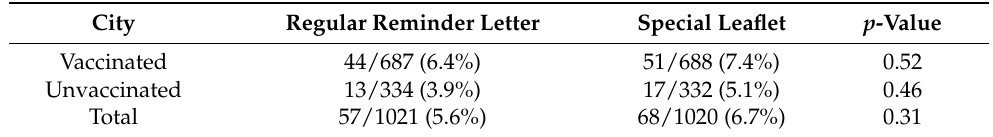
Table 5. Cervical cancer screening rates for women aged 20 or 21 in Hirakata City, in vaccinated and unvaccinated women, after receiving regular reminder letters or specially tailored leaflets according to vaccination